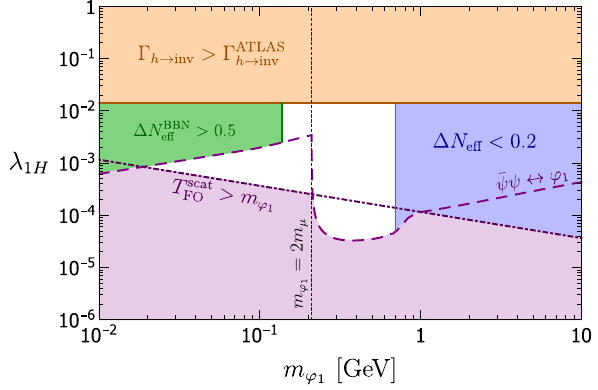
Fig. 2 Parameter space allowing to alleviate the Hubble tension (white). The blue region corresponds to values than cannot alleviate substantially the Hubble tension, while the green area represents BBN constraintson (cid:2) N eff estimatedinRef.[7].Theorangeregionisexcluded by constraints from ATLAS [70] on Higgs invisible decay as detailed in Sect.4.3. The dashed purple line is determined from the (inverse) decay thermalization critera of Eq.(4.7) and the dash-dotted purple line < T scat corresponds to m ϕ with T scat obtainedfrom Eq.(4.4). Thepur- FO FO 1 ple region represents the parameter space beyond the range of